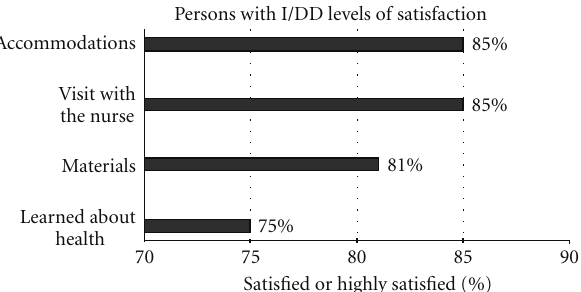
Figure 1: Rating of satisfaction by persons with I/DD with geriatric and oral health